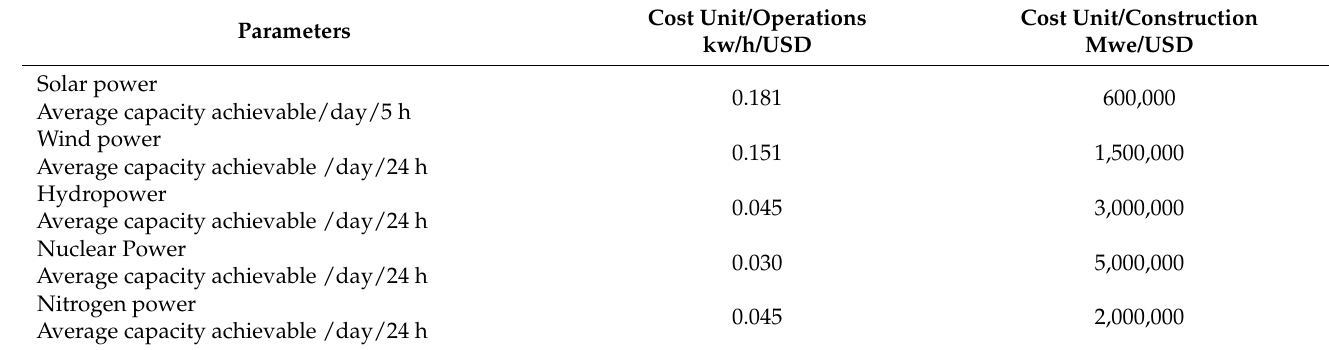
Figure 3. Diagram design of a complete circulating electric power technology circuit. Table 5. Cost comparison for the implementation and construction of the technology Table 3. Technology for interfacing with cyclic power generation circuits in the system.